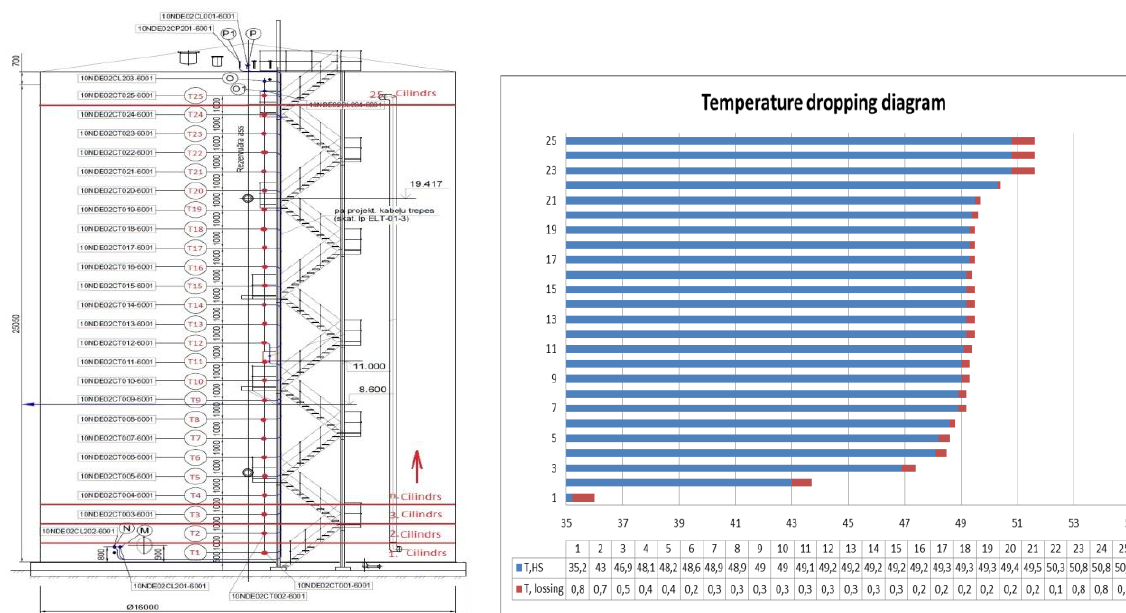
Figure 5. Location of heat accumulator temperature sensors and temperature drops from 31.08.2020. until 07.09.2020.